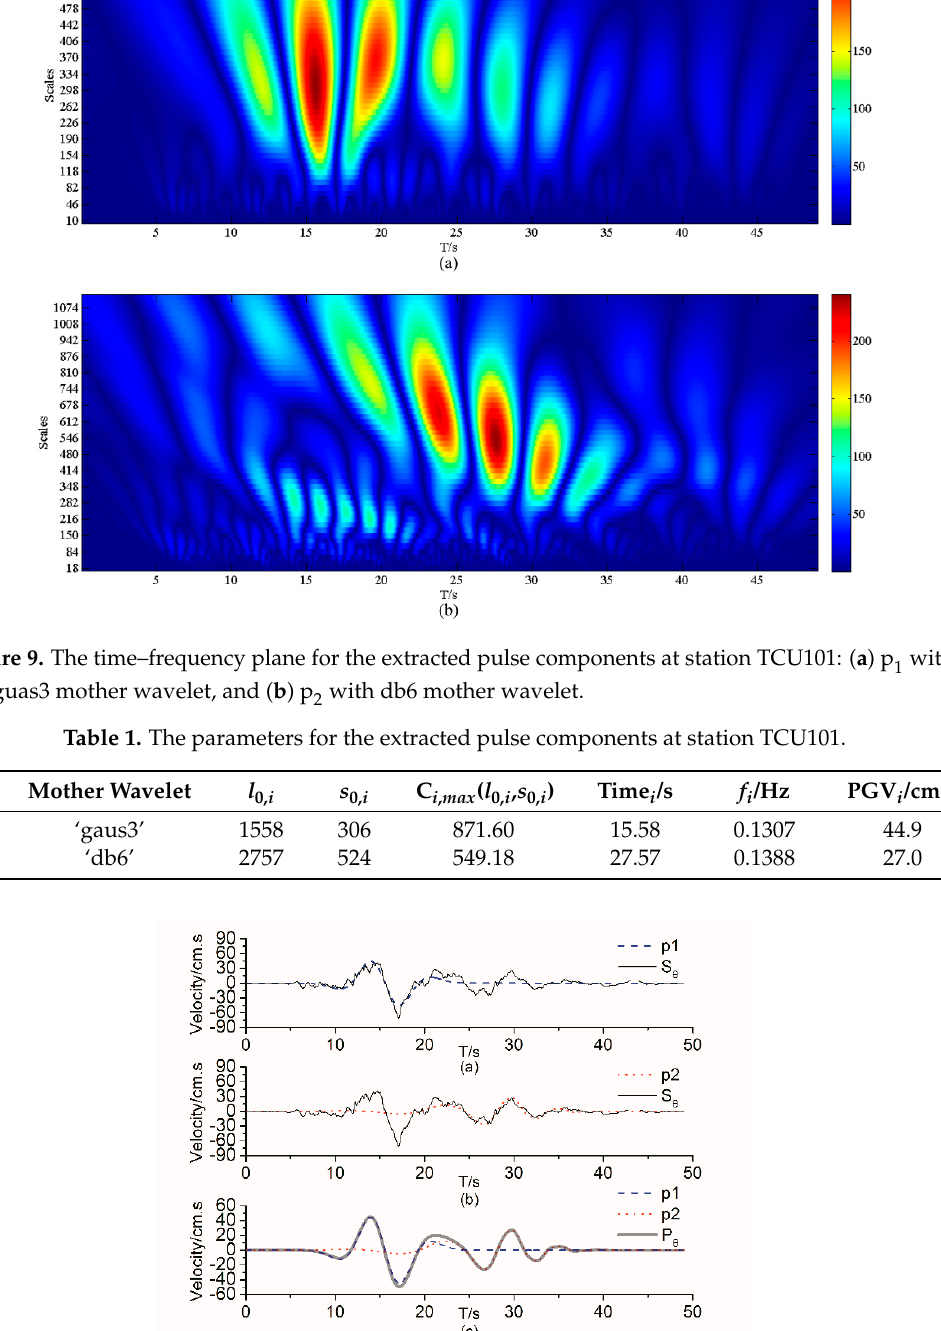
Figure 10. The extracted dominant pulse components embedded in 𝑺 (cid:2968) at station TCU101: ( a ) p (cid:2869) , ( b ) p (cid:2870) , and ( c ) 𝑷 (cid:2968) .